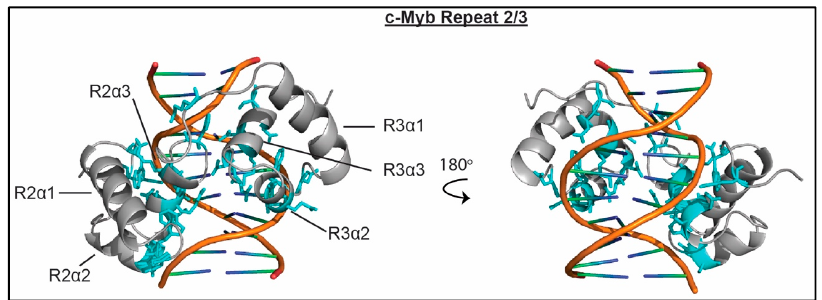
Figure 7. The molecular mechanism of SANT/Myb association with nucleic acid. The NMR structure of the murine cMyb SANT/Myb repeats 2 and 3 with a 26bp dsDNA containing the cognate sequence TAACGG (PDBID 1MSF) is shown. Residues important for complex formation are shown as cyan sticks.